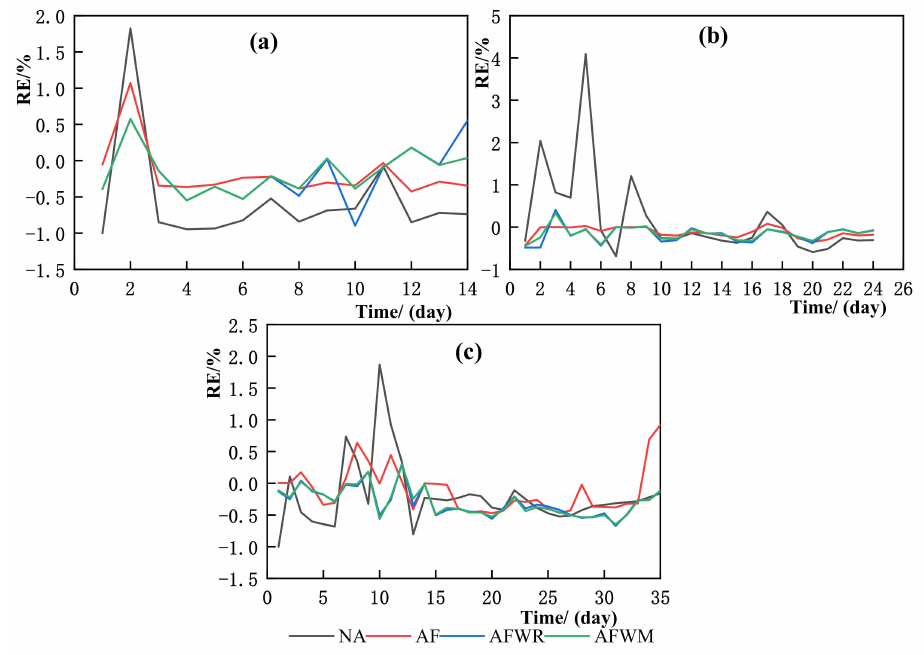
Figure 8. RE values under the four assimilation settings for medium floods for the three stations: ( a ) Dage; ( b ) Gubeikou; ( c )